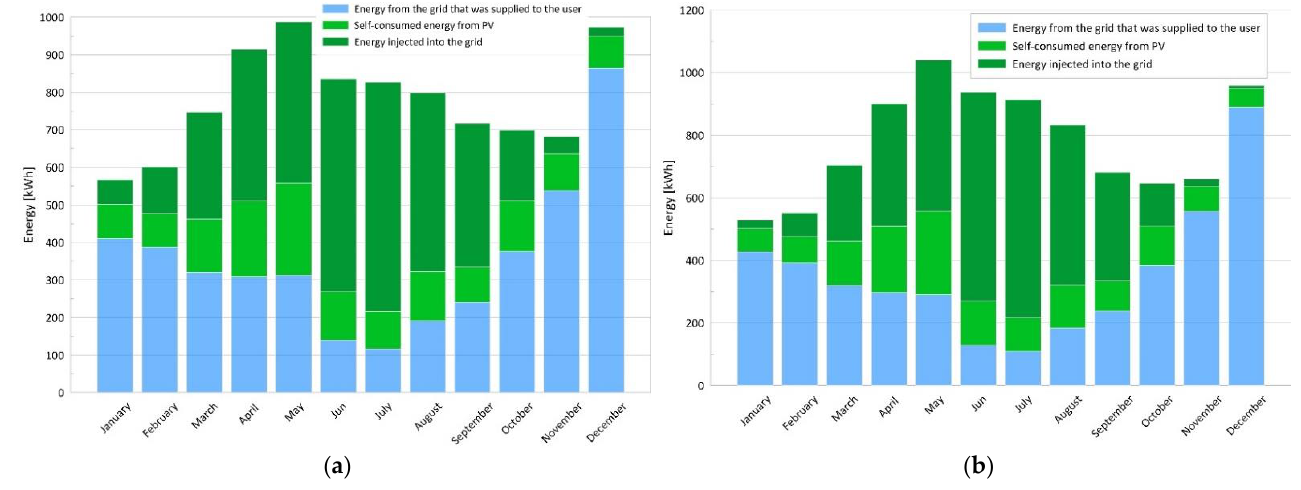
Figure 3. Comparison of the household monthly energy distribution for a PV system facing South ( a ) and East – West ( b ).